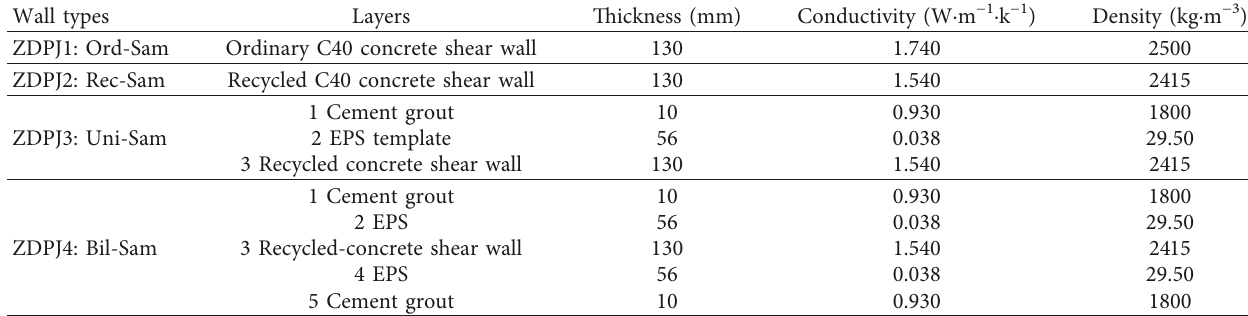
Table 1: Wall types and material